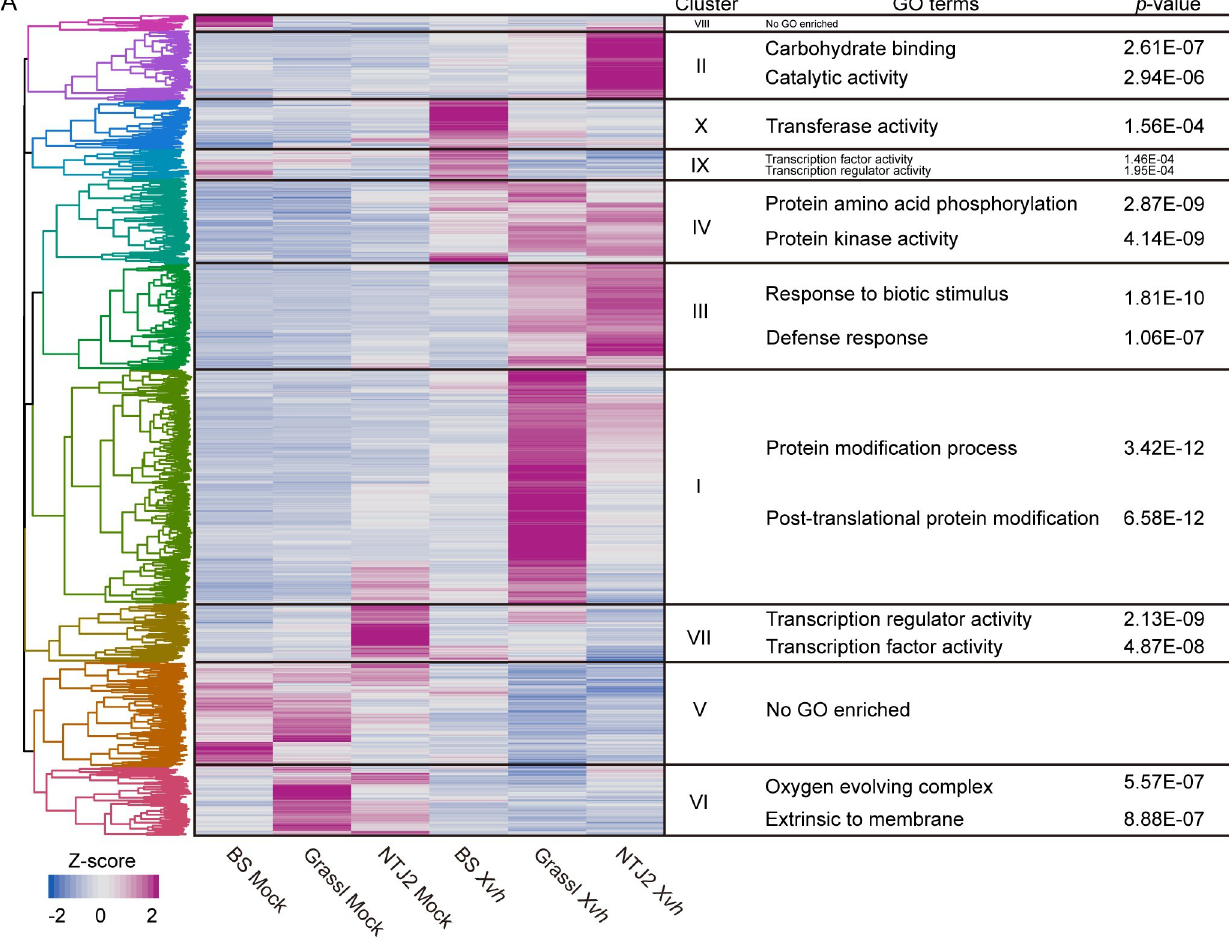
Fig 7. Hierarchical clustering analysis of differentially expressed genes in Sorghum. Analysis based on gene expression from mock and Xvh -infected sorghum samples. Sorghum genes identified as differentially expressed in at least one of the pairwise comparisons between mock and Xvh- infected sorghum (FDR adjusted p value < 0.05, |log 2 fold change| > 2) were included in this analysis. The transformed Z-score value was generated from FPKM (fragments per kilobase per million mapped sequence reads) values for each condition. The top 2 GO terms based on p value (adjusted by the Benjamini-Hochberg method) are listed in this figure. The complete lists of GO terms are provided in S11 Table. BS (water-soaked lesions), Grassl (red lesions), and NTJ2